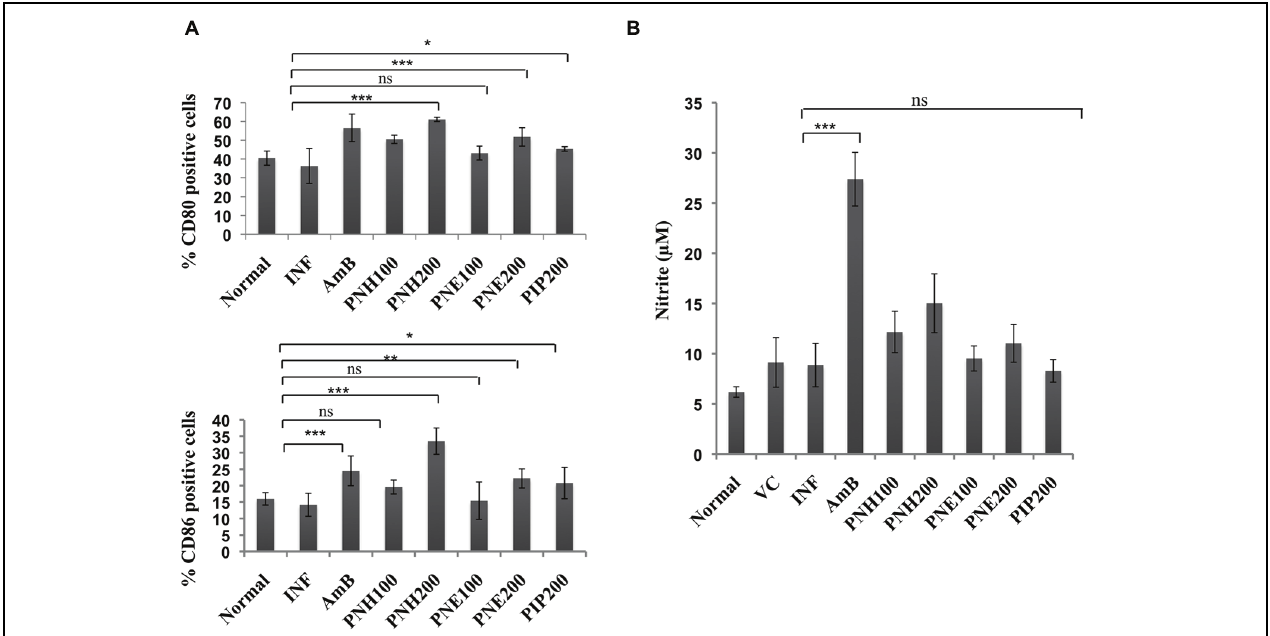
FIGURE 9 | Assessment of immunomodulatory effect of bioactive fractions on murine macrophages. (A) Estimation of CD80 and CD86 expression. Peritoneal macrophages from different treatment groups were exposed to surface staining with antimouse-CD80-APC and antimouse-CD86-PeCy7 along with appropriate controls. Individual percentages of CD80 and CD86 positive cells for each group were deduced with the help of BD FACS DIVA software. ∗∗∗ P < 0.001, ∗∗ P < 0.01, ∗ P < 0.05, and ns = non-significant with respect to INF. (B) Assessment of in vivo NO production. Culture supernatants from splenocytes of all the experimental groups were isolated and incubated with equal volume of griess reagent for NO estimation as described in methodology section. ∗∗∗ P < 0.001 and ns = non-significant with respect to